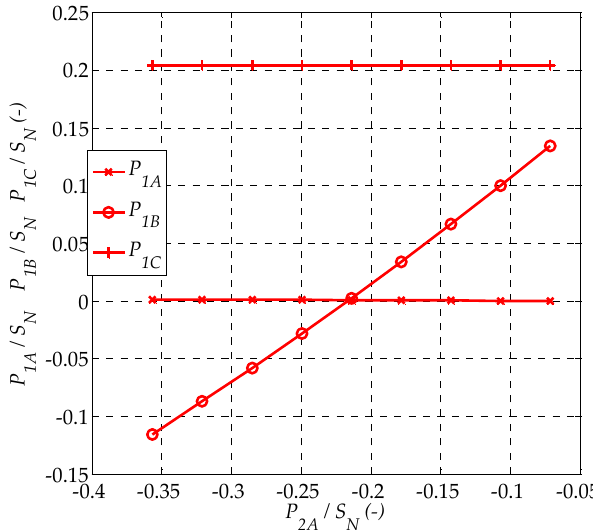
Figure 10. Active powers of the phases of the primary side of the transformer at the load RL (p.f. = 0.8) of phases B and C of the secondary side, as a function of the active power of the prosumer source in phase A of the secondary side, with amplitude–phase control.